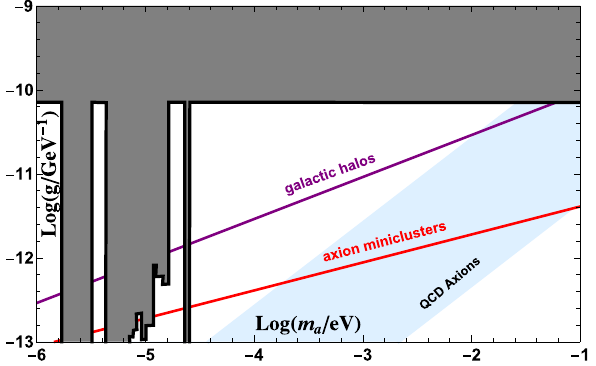
Fig. 3 Picture of the axion search in a small region of the parameter space ( m a , g ) . The gray region is the space of parameters excluded by experiments (see Ref. [30]). Condition (27) is satisfied above the red and purple line for axion miniclusters and galactic halos assuming that the caustic ring model is correct. These lines were plotted using Eqs. (32) and